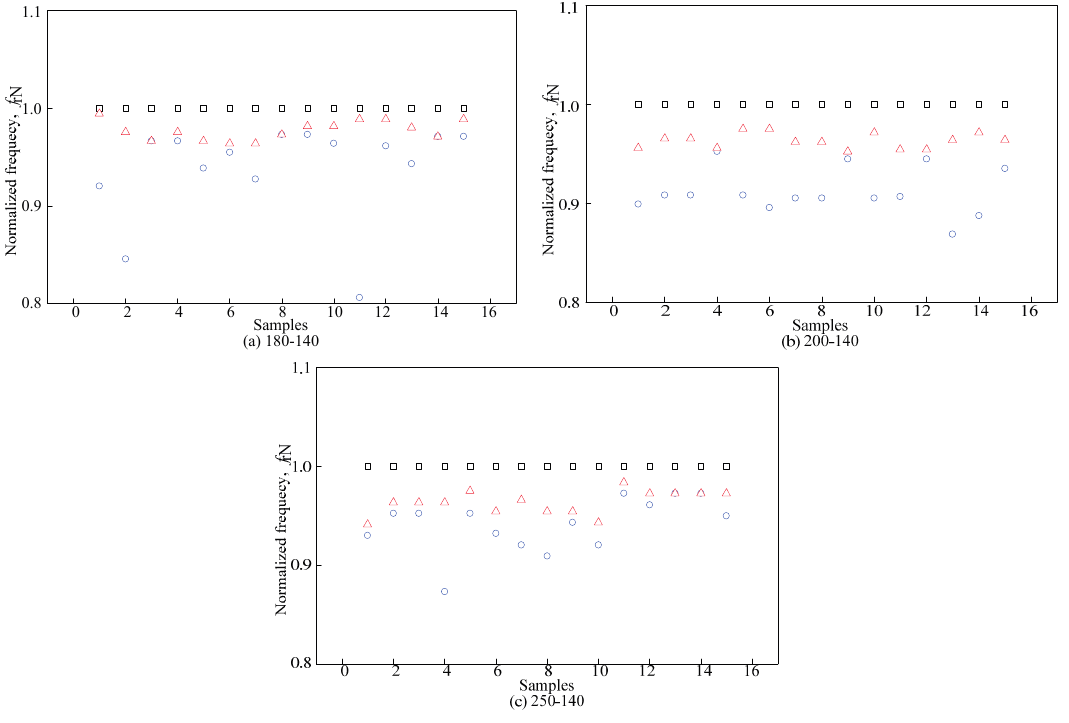
Figure 8. Normalized resonant frequency of the first peak for each coil’s turns configuration. □ air ∆ ripe ○